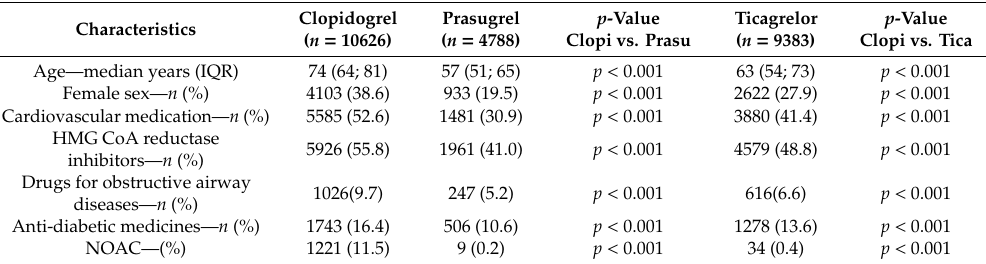
Figure 1. Flowchart of patients with discharge diagnosis of acute coronary syndrome. Table 1. Patients characteristics and disease-specific medication before index ACS